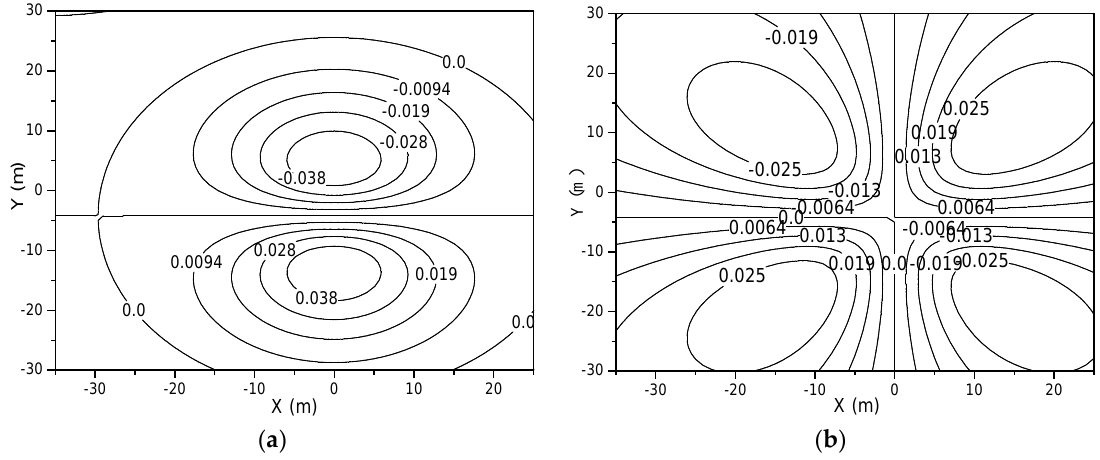
Figure 12. Ground movements caused by f s : ( a ) Settlement; ( b ) Horizontal displacement.